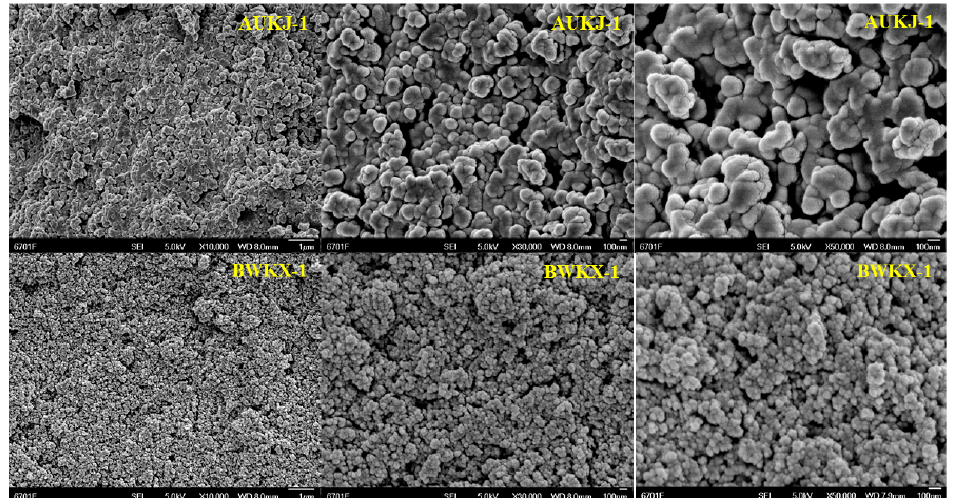
Figure 4. The SEM images of the internal structure of AUKJ-1 and BWKX-4 after grinding at a magnification of 10,000×, 30,000× and 50,000×.